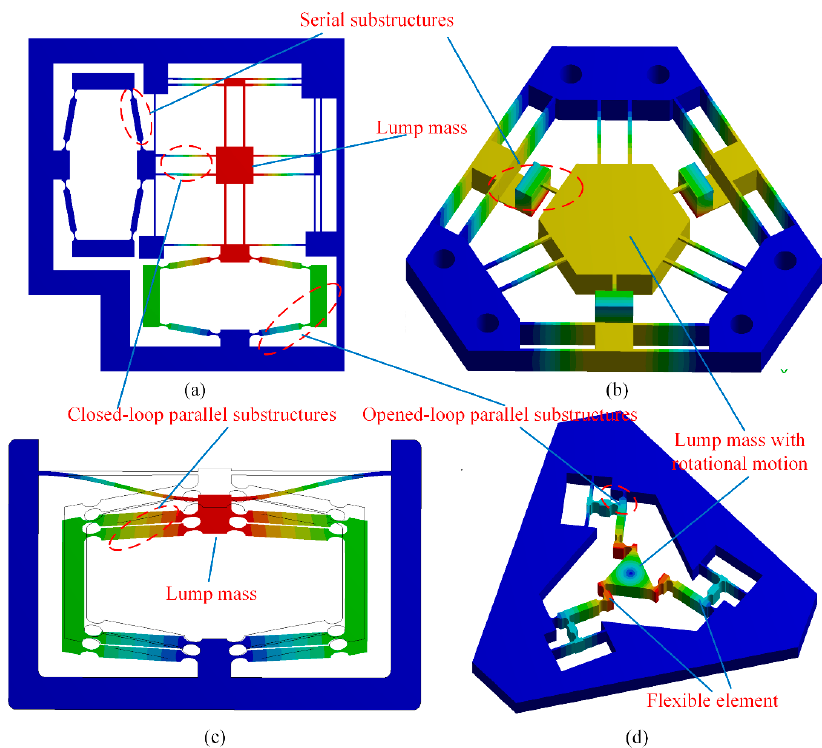
Figure 3. Typical compliant mechanisms: ( a ) a XY monolithic precision platform [35]; ( b ) a mono- lithic tip-tilt-piston spatial compliant manipulator [35]; ( c ) a one-dimensional precision positioning platform [38]; ( d ) a 3-DOF precision positioning platform [24,35].